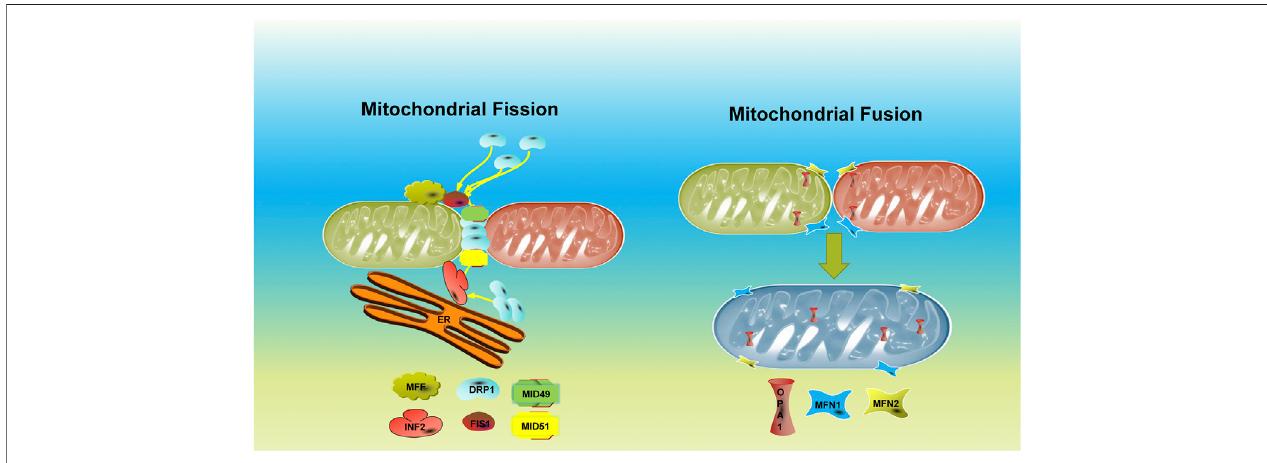
FIGURE 1 | Schemes and fundamental regulators of mitochondrial